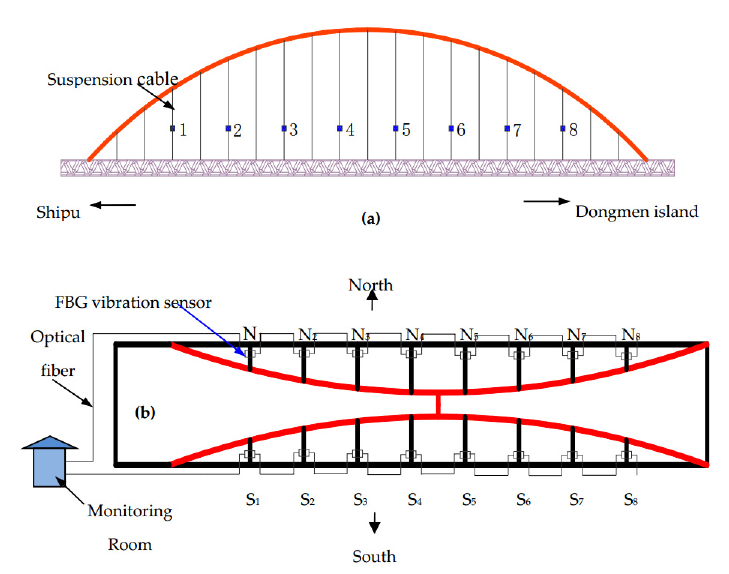
Figure 11. Arrangement of fiber Bragg grating (FBG) vibration sensors on Tongwamen bridge cables: ( a ) side view; ( b ) overhead view [152].